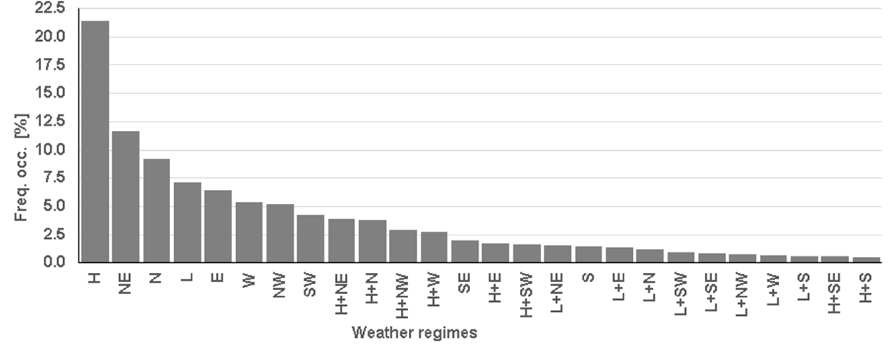
Figure 4. Weather circulation types—frequency of occurrence from 1950 to 2019 (70 years).